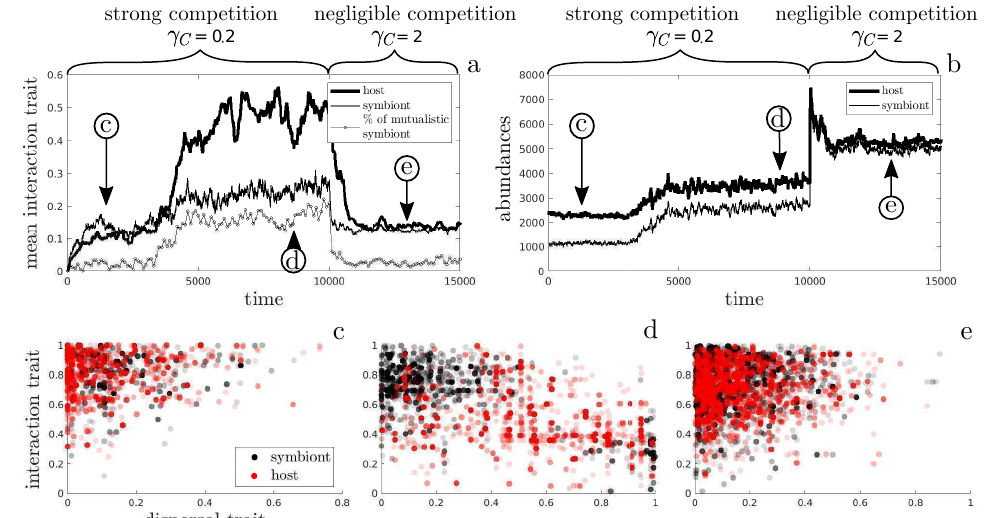
Figure SI.9. The transition to mutualism and collapse of mutualism depending on competition. a) Host and symbiont average interaction traits and the percentage of mutualistic symbionts over time. b) Host and sym- biont abundance. There is strong competition from time t = 0 to t = 10 t = 10 4 to the end. c) Dispersal and interaction traits distribution before the transition to mutualism. d) Dispersal and interaction traits distribution during mutualism persistence. e) Dispersal and interaction traits distribution after mutualism collapse. Parameters are m = 0 . 06 , c m = 0 . 3 , w h = 1 , f f max = 8 , f a = 0 . 5 , β max = 0 . 5 and d = 0 .